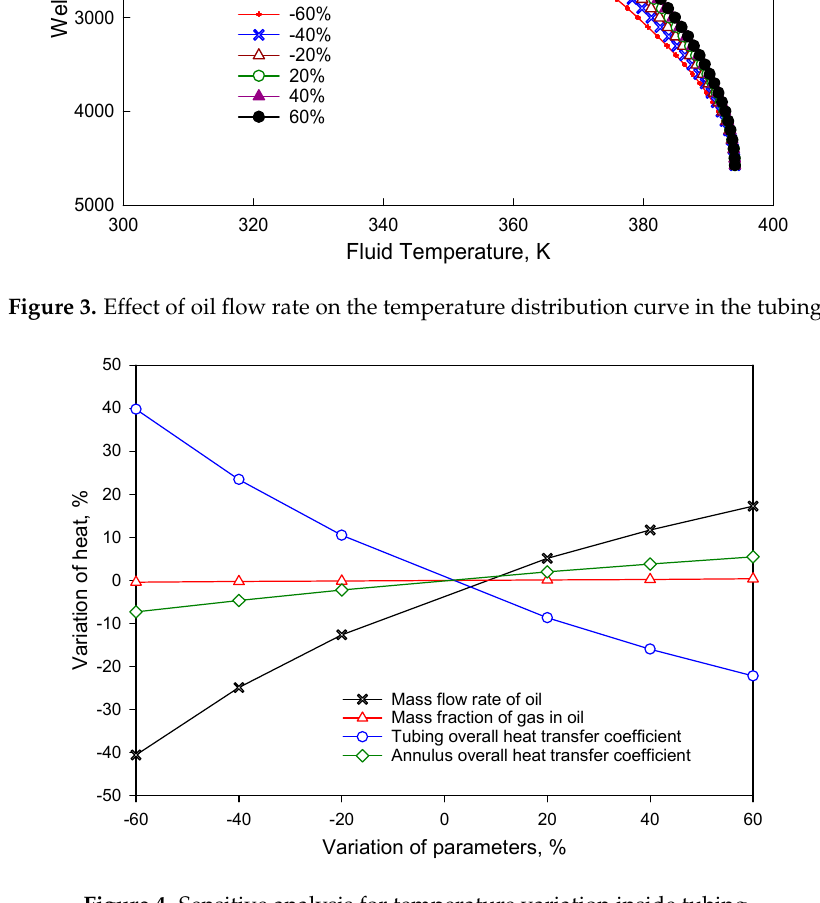
Figure 4. Sensitive analysis for temperature variation inside tubing. Table 3. Influence of factors on temperature within the tubing.